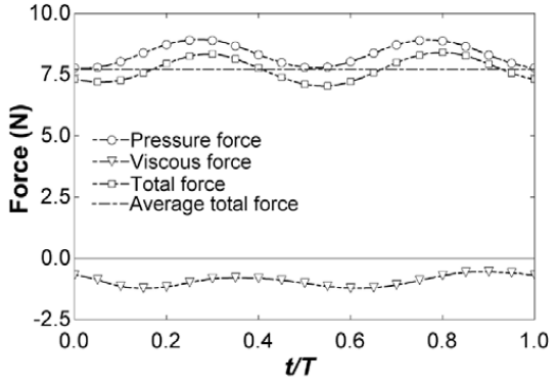
Figure 5. Time variation of the average total, total, instantaneous, and viscous forces for anguilliform swimming [50].